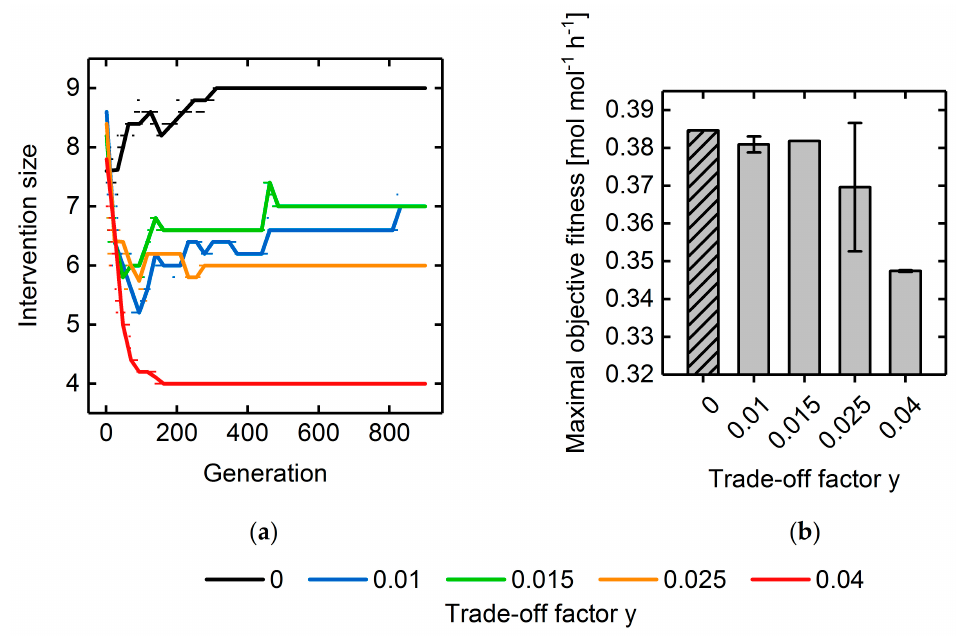
Figure 10. ( a ) Progressions of the intervention size of the fittest individual throughout GA runs, in which the transformed fitness function was used (cf. Equation (9)) to consider the minimization of the number of deletion targets (cf. Section 2.3.3). Values between 0 and 0.04 were employed for the trade-off factor y to investigate its influence on trade-off between the objective fitness and the number of simultaneous perturbations. Dots illustrate the mean intervention size over a population at a specific generation. The lines represent the corresponding linear interpolations. For the same simulations, the final objective fitness values are shown in Subfigure ( b ).